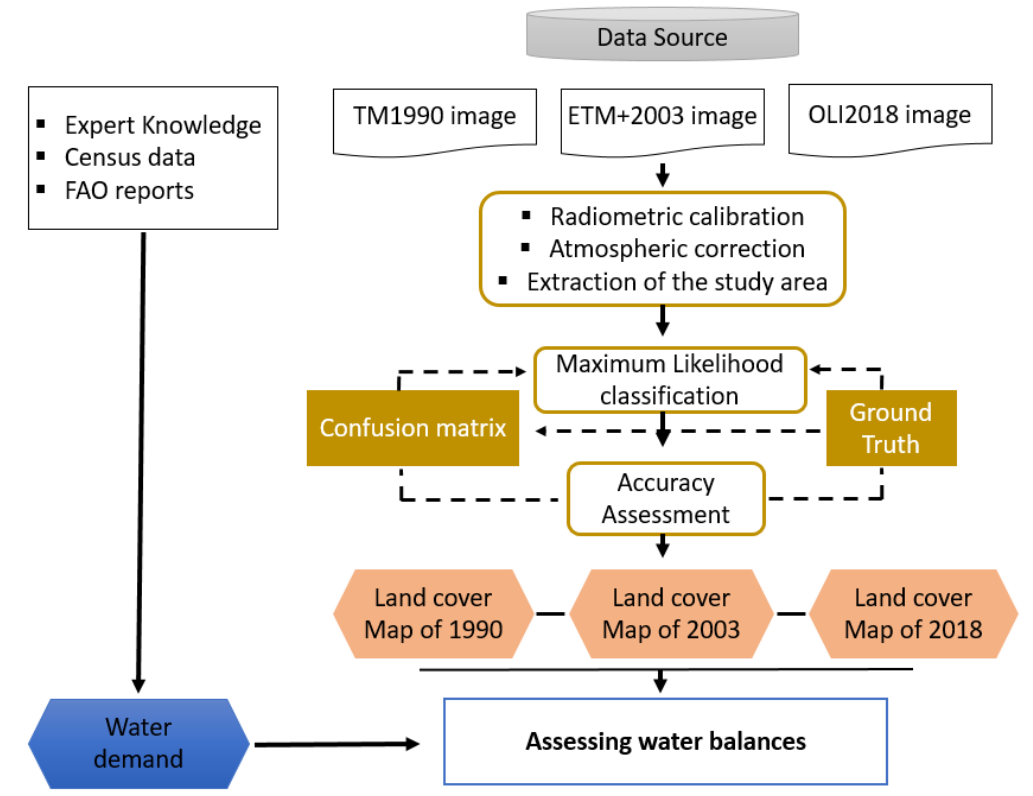
Figure 2. Flowchart of the implemented methodology.